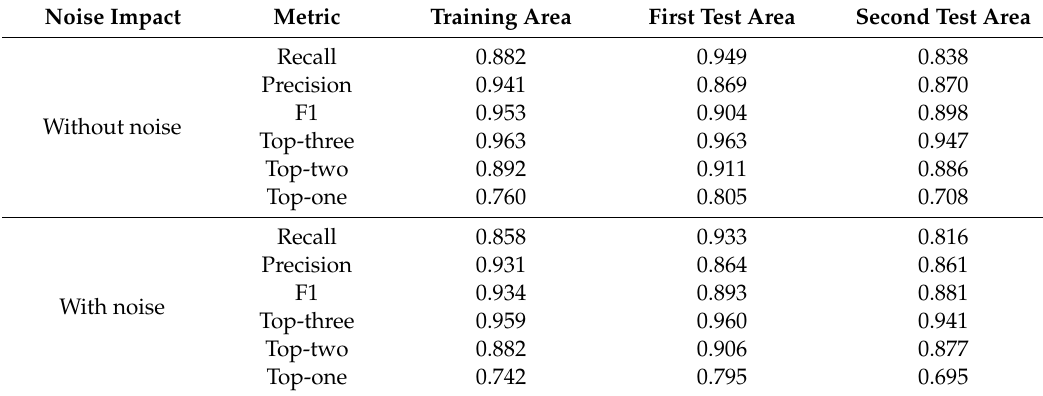
Table 5. Impact of Gaussian noise (mu = 0, sigma = 0.1) on feature extraction for first and second